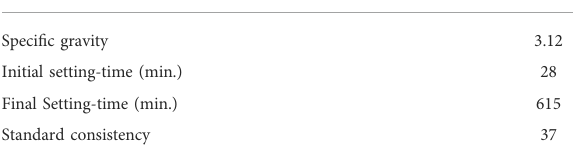
TABLE 2 Physical Properties of cement. Characteristics